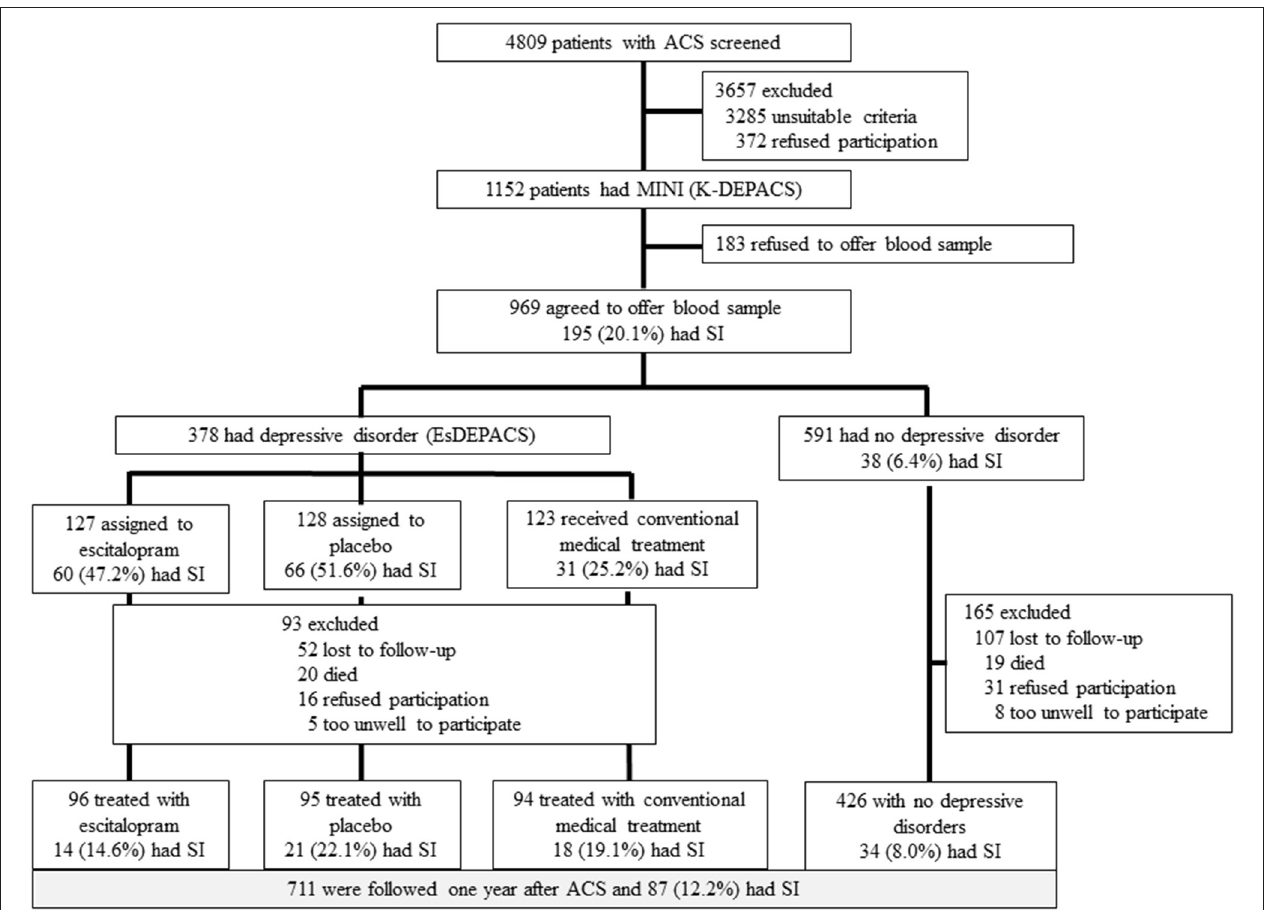
FIGURE 1 | Flow diagram of the recruitment procedure. ACS, acute coronary syndrome; MINI, Mini-International Neuropsychiatric Interview; SI, suicidal ideation; K-DEPACS, Korean DEPression in Acute Coronary Syndrome study; EsDEPACS, Escitalopram for DEPression in Acute Coronary Syndrome study.